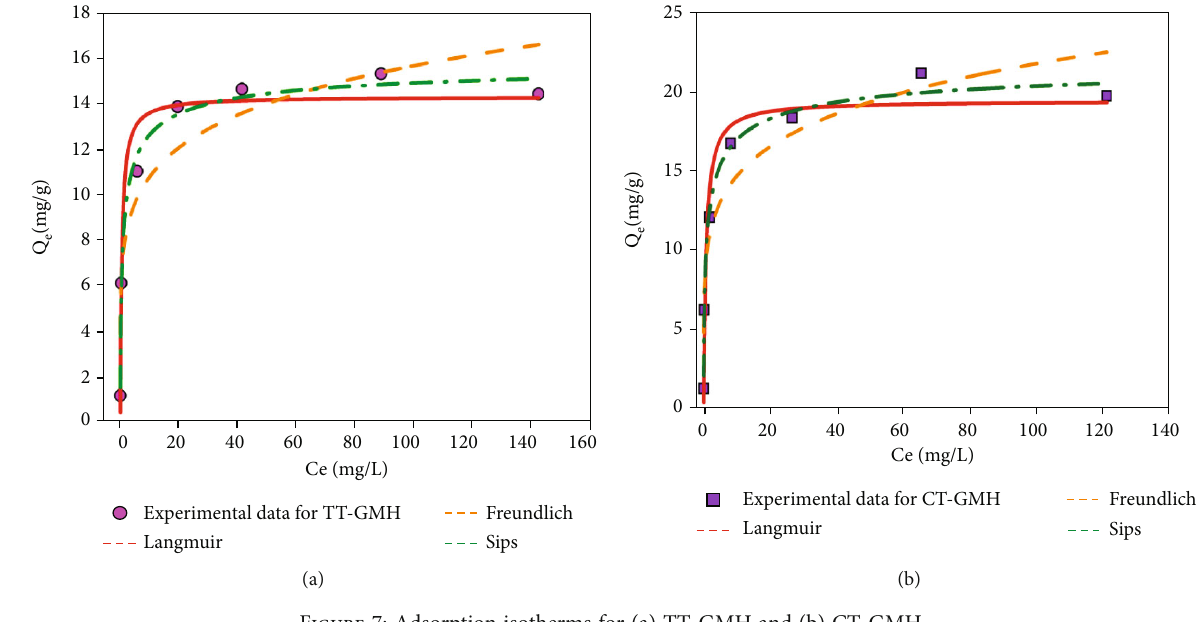
Figure 7: Adsorption isotherms for (a) TT-GMH and (b) Table 3: Isotherm parameters for adsorption of Cr(VI) onto TT-GMH and CT-GMH.